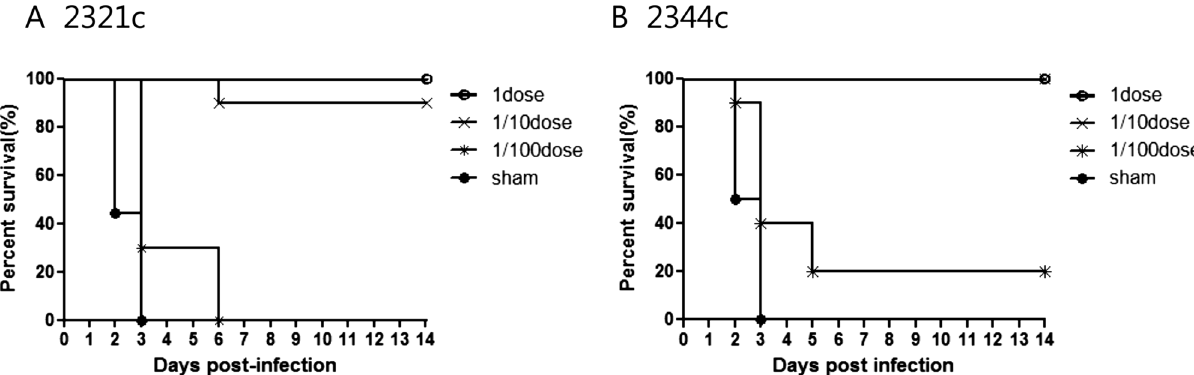
Figure 2. Survival of vaccinated chickens challenged with each homologous HPAIV. Survival of sham- vaccinated chickens and chickens inoculated with one (1) dose, one-tenth (1/10) dose, or one-hundredth (1/100) dose of the multi-clade VLP and then challenged with each homologous H5 HPAIV: ( A ) KA435/2.3.2.1c. ( B ) ES2/2.3.4.4c.